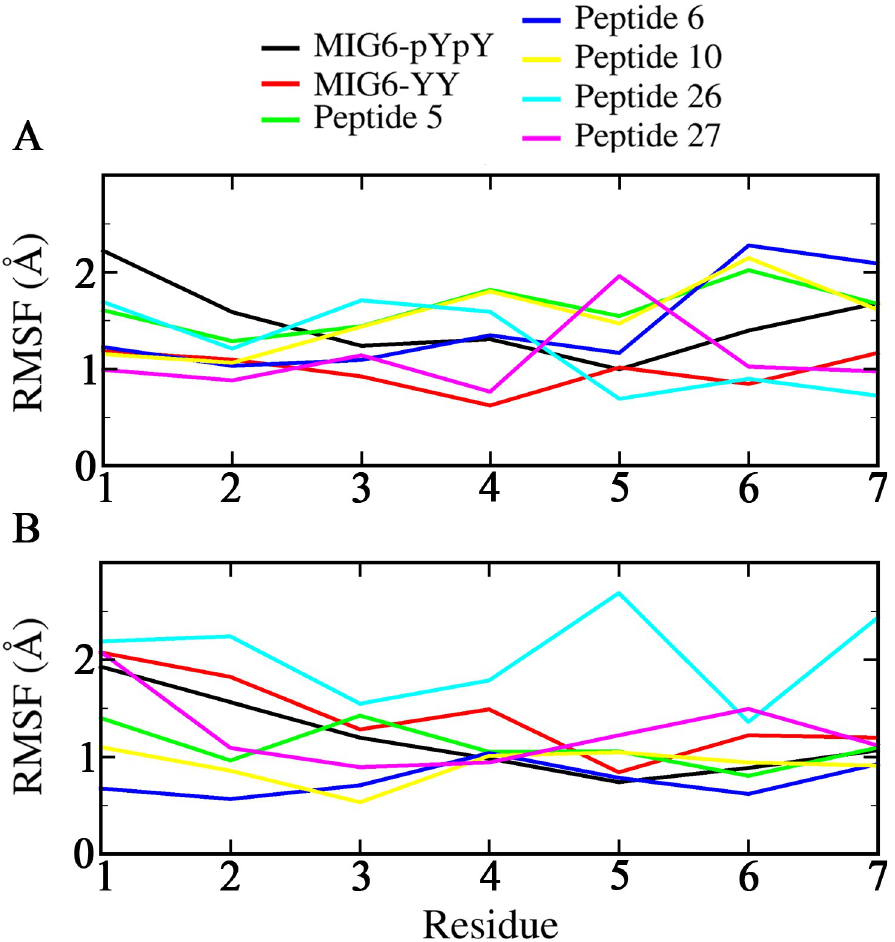
Fig 4. RMSF graph of all peptides in interaction with both EGFRs. Peptides MIG6-pYpY, MIG6-YY, 5, 6, 10, 26 and 27 in interaction with (A) EGFRL858R and (B) WT-EGFR.